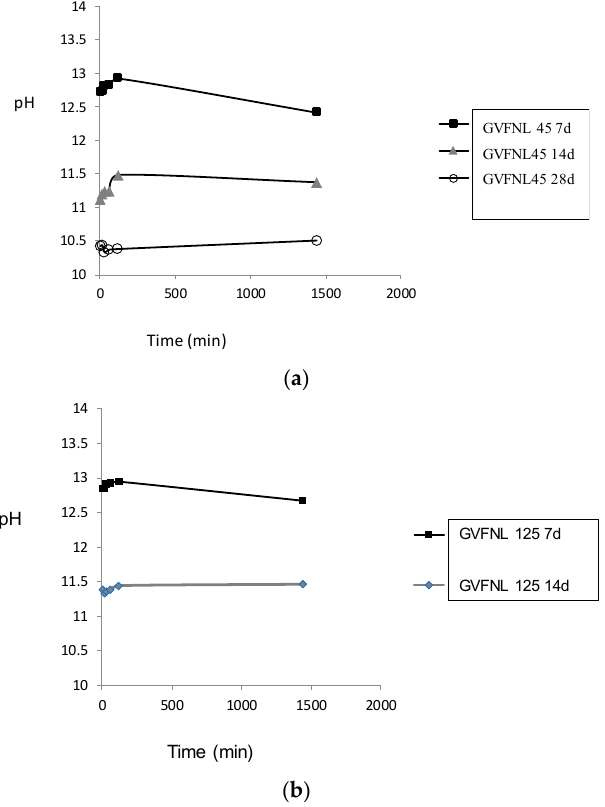
Figure 2. pH vs time trend of geopolymers containing ( a ) VFNL < 45 µ m and ( b ) VFNL < 125 µ m as a function of curing time.